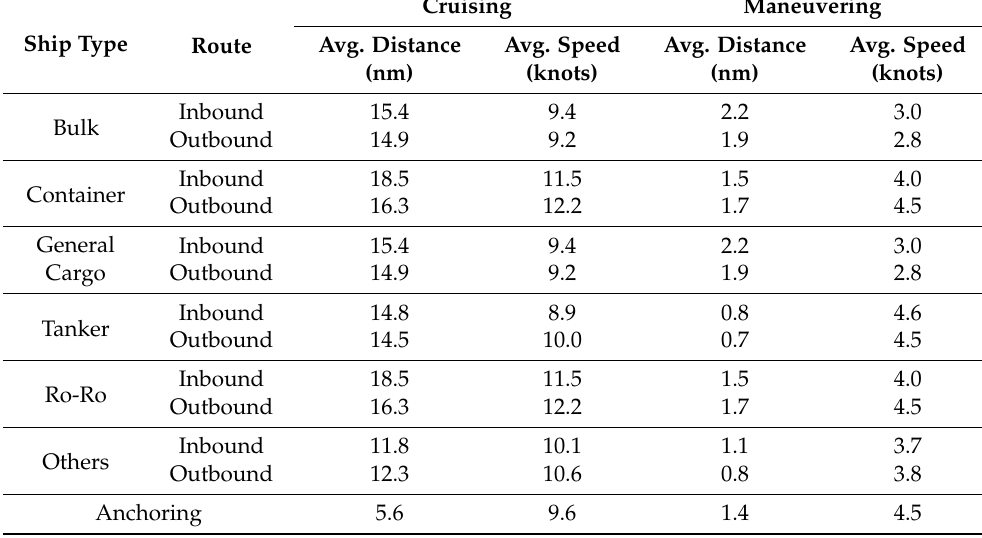
Table 4. Average distance and speed of each ship type in cruising and maneuvering